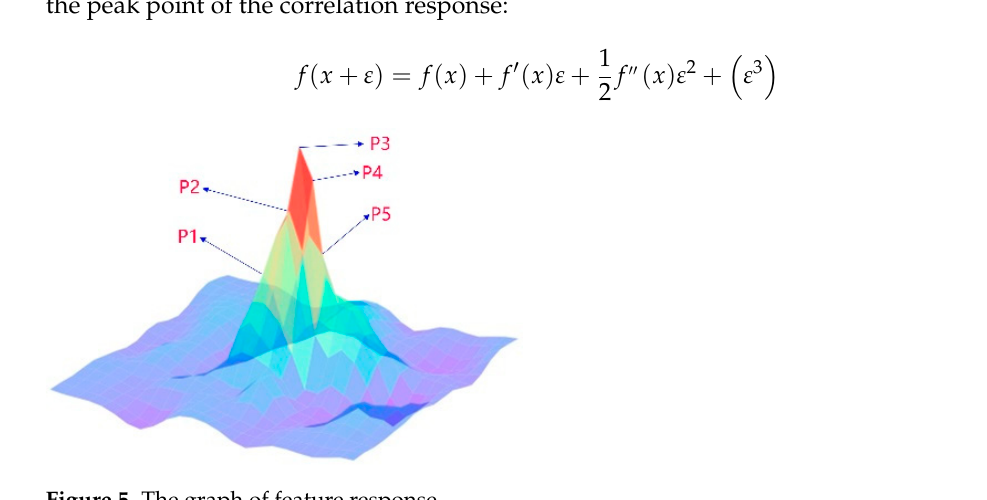
Figure 5. The graph of feature response.